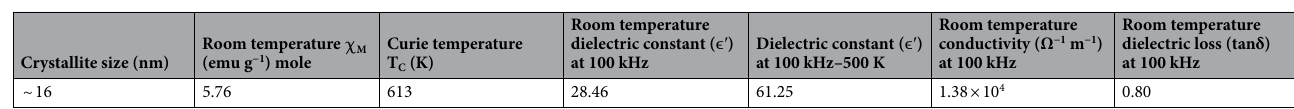
Table 3. General properties of the synthesized MFs NPs spinel